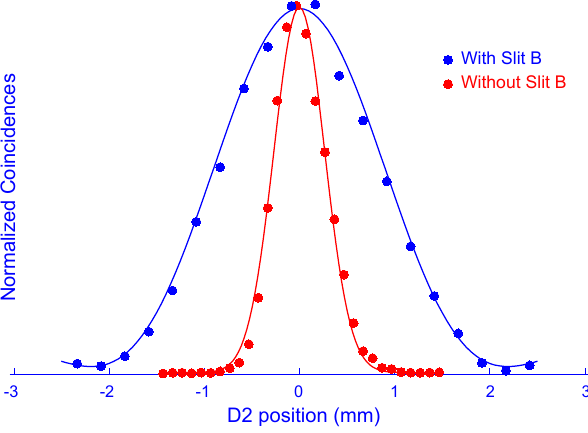
Figure 3: Results of the photon experiment by Kim and Shih aimed at realizing Popper’s proposal. The di ff raction pattern in the absence of slit B (red circles) is much narrower than that in the presence of a real slit (blue